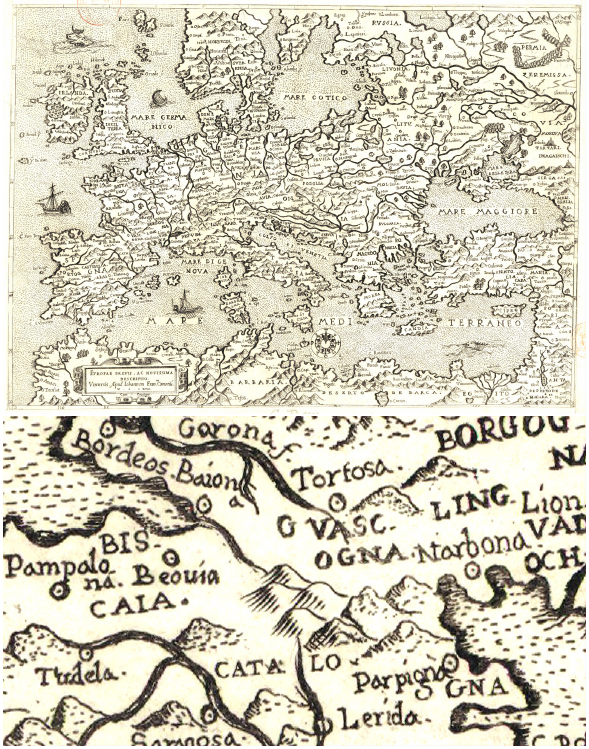
Figure 4: Unknown cartographer, 1568, Europæ brevis : No obvi- ous border